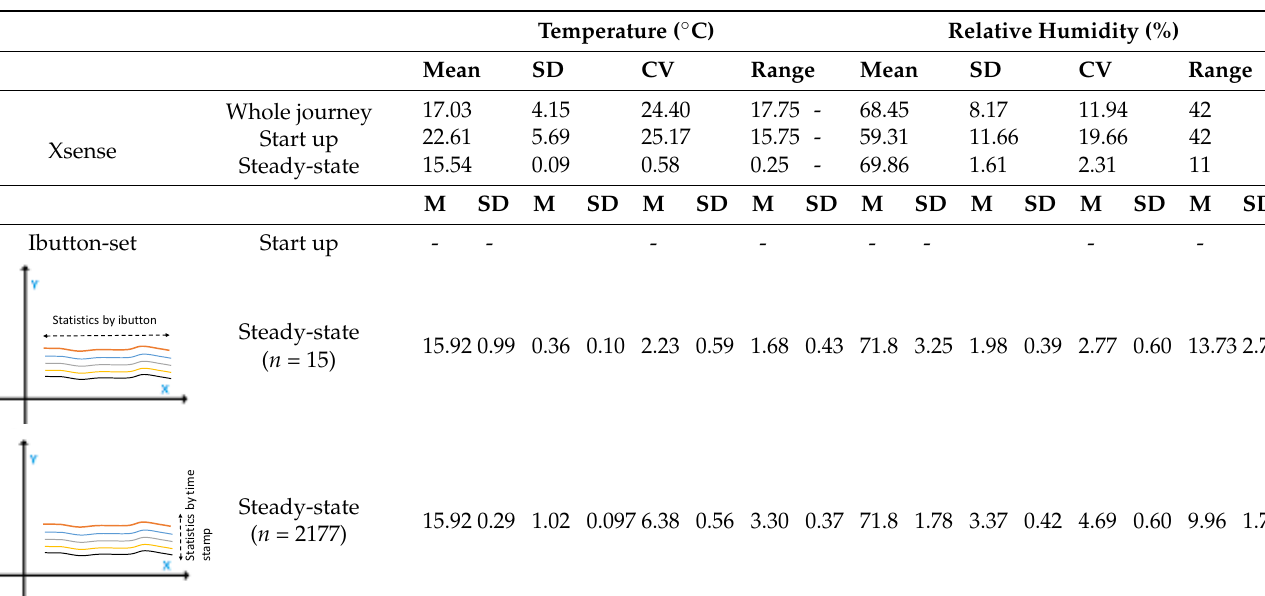
Table 3. Summary of temperature and relative humidity statistics (M: mean, SD: standard deviation, CV: coefficient of variation) inside the reefer throughout the whole transport itinerary (Jandaíra, Brazil to Castellón, Spain).